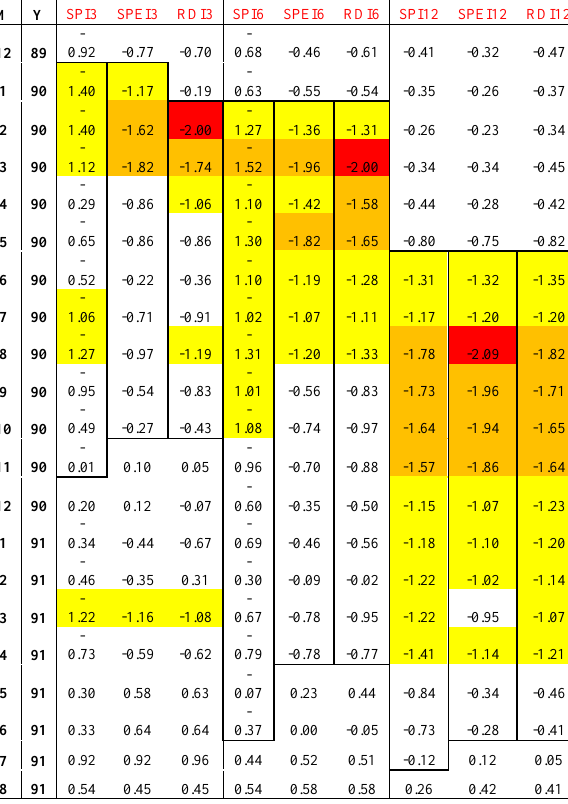
Table 4. The drought of 1990 for SPI, SPEI, and RDI. The bold boundaries enclose the drought event.